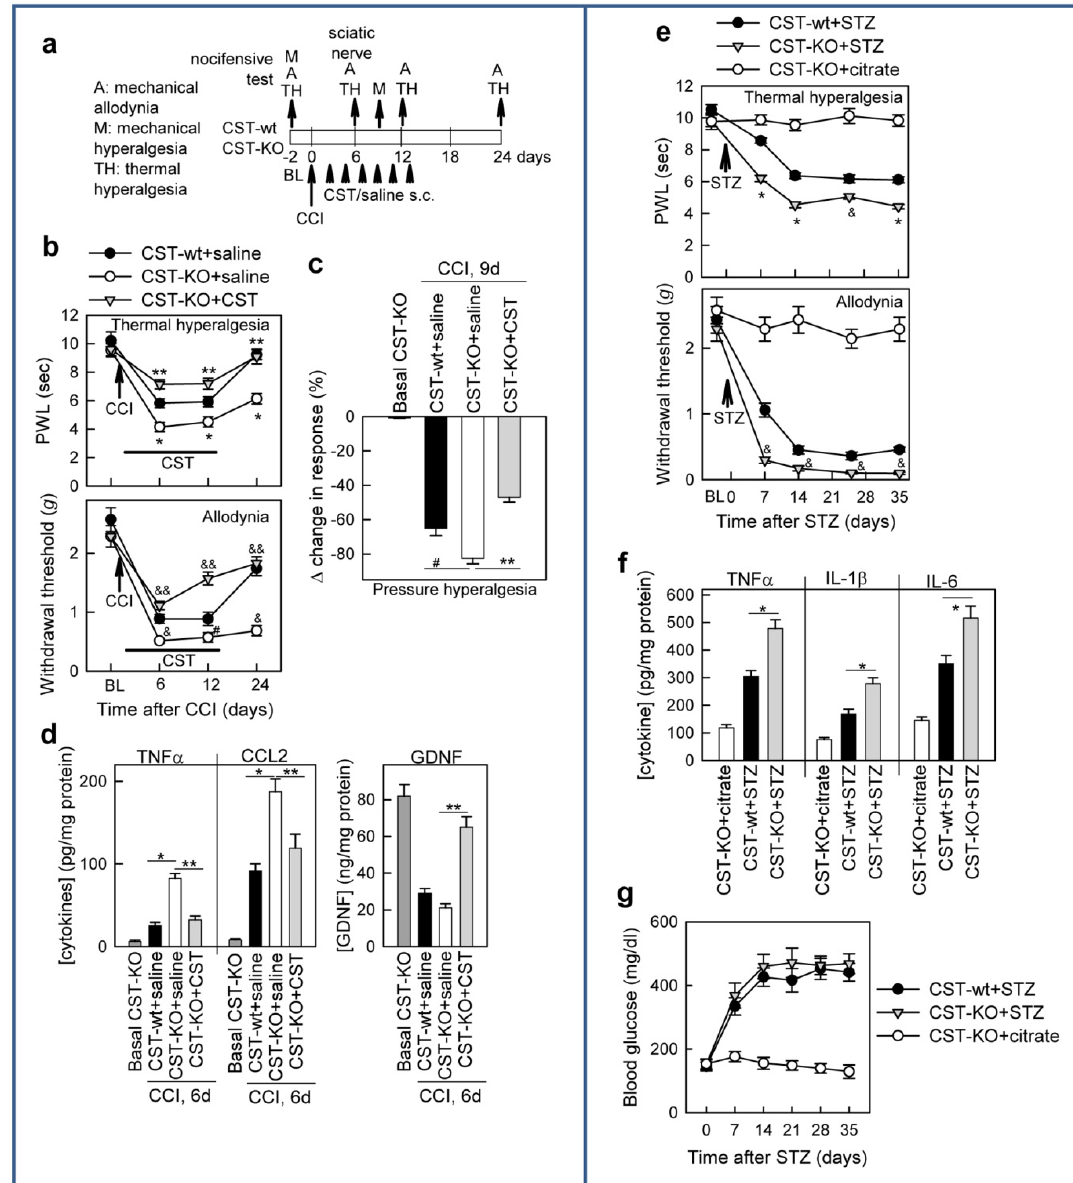
Figure 7. Deficiency in cortistatin exacerbated neuropathic pain in various models of peripheral nerve injury. ( a – d ) Effects of cortistatin deficiency (CST-KO mice) on the development of thermal hyperalgesia ( b , upper panel), mechanical/tactile allodynia ( b , lower panel), and mechanical pressure hypersensitivity ( c ) in hind paws (ipsilateral to injured nerve) after CCI of sciatic nerve in comparison to wild-type mice (CST-wt). Reversion of the exacerbated nocifensive responses to CCI of sciatic nerve observed in CST-KO mice by local s.c. cortistatin treatment was evaluated, as indicated in the scheme ( a ). The levels of inflammatory cytokines and GDNF in protein extracts of sciatic nerves isolated six days after CCI-surgery are shown ( d ). n = 6–7 mice/group. * p < 0.0001, & p < 0.01, # p < 0.05 between CST-KO and CST-wt mice. ** p < 0.0001, && p < 0.01, between saline-treated and CST-treated CST-KO mice. ( e – g ) Effects of cortistatin deficiency (CST-KO mice) on the development of thermal hyperalgesia ( e , upper panel) and mechanical allodynia ( e , lower panel) in hind paws during the course of diabetes induced by high-dose of streptozotocin (STZ) in comparison to wild-type mice (CST-wt). The levels of inflammatory cytokines in protein extracts isolated from sciatic nerves 28 days after STZ injection are shown ( f ). Nondiabetic CST-KO mice injected with citrate buffer instead of STZ were used as controls of reference. The course of diabetes was monitored by measuring the glucose levels in blood ( g ). n = 6–7 mice/group. * p < 0.0001, & p < 0.01 between CST-KO and CST-wt STZ-diabetic mice. All data represent mean ± SEM.